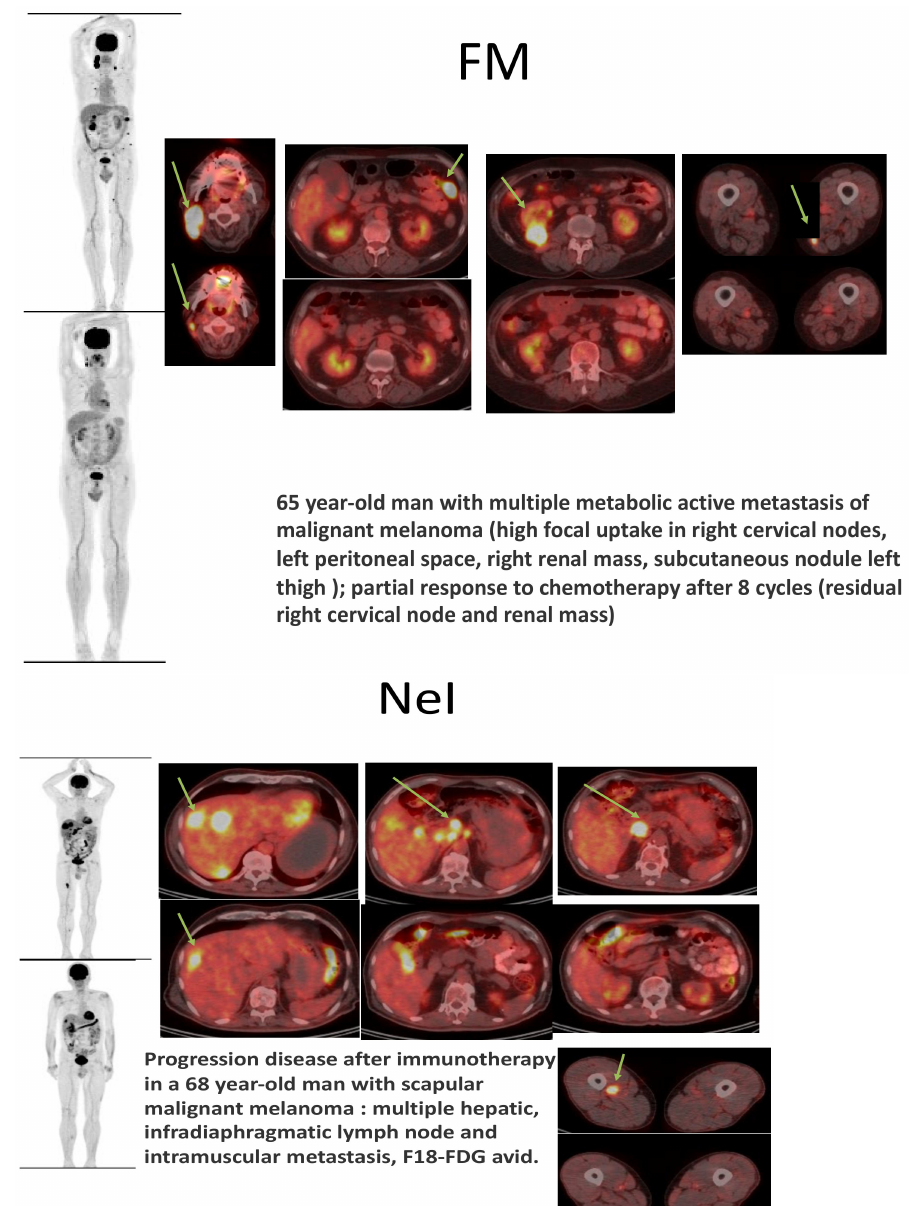
Figure 3. Malignant melanoma and various aspects of metastatic spread, as identified and depicted by